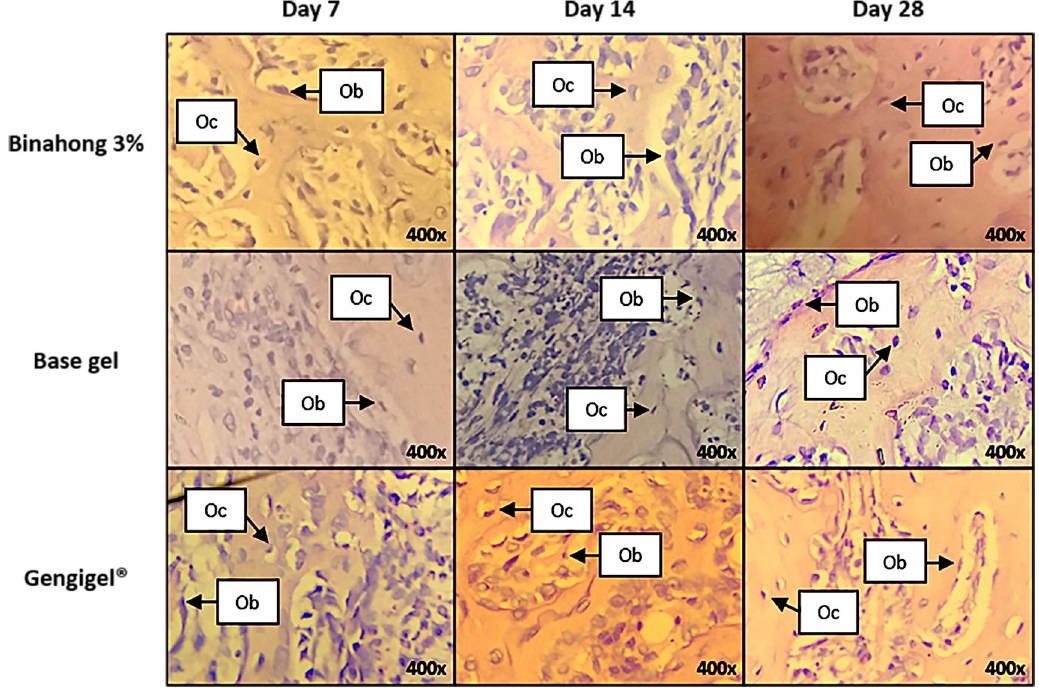
Figure5.Histopathologicalobservationofosteoblastsandosteocytesinthealveolarbonehealingofsockets. The observation was conducted on the 7 th , 14 th , and 28 th day post-extraction socket wounds stained with haematoxylin-eosin. (Abbreviations: Ob: osteoblasts; Oc: osteocytes ( (cid:1)